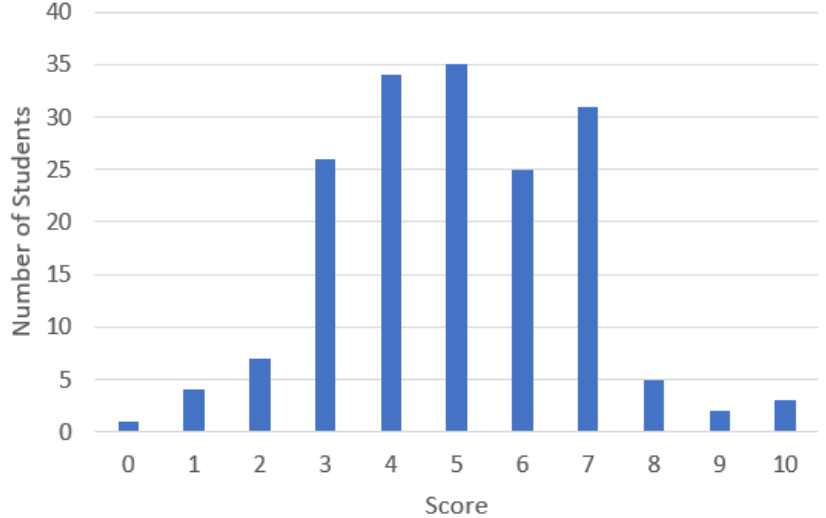
Figure 7. Distribution of students’ scores in the quantum technologies inventory (QTI). See text for details.